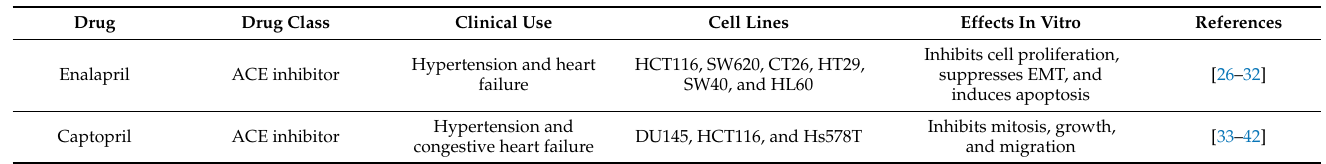
Table 1. Vasodilator drugs against different types of cancer. The table shows only the vasodilator drugs tested on tumor cell